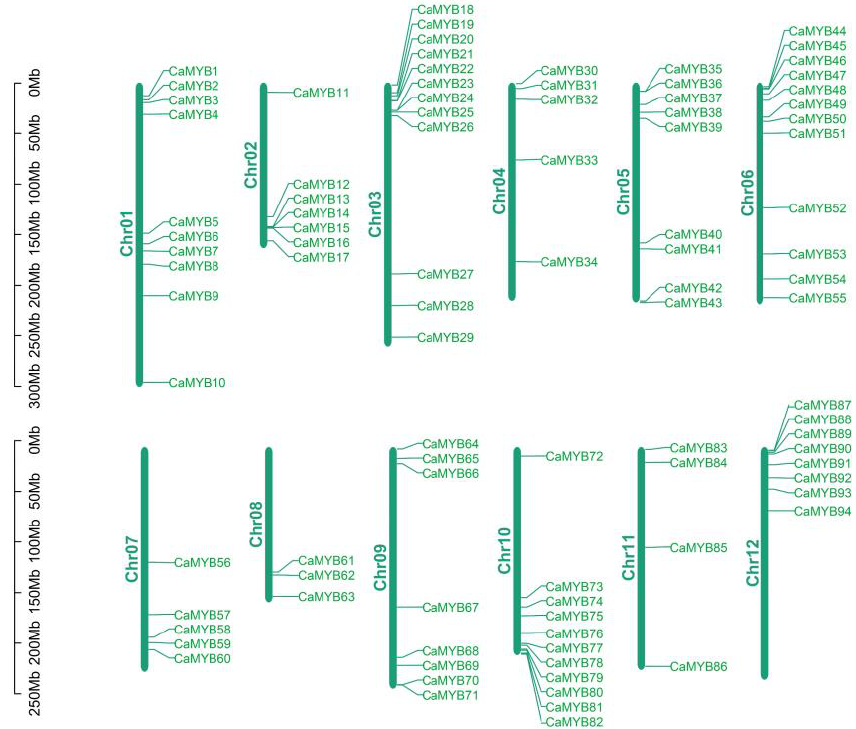
Figure 1. Chromosomal locations of CaMYB -related genes.